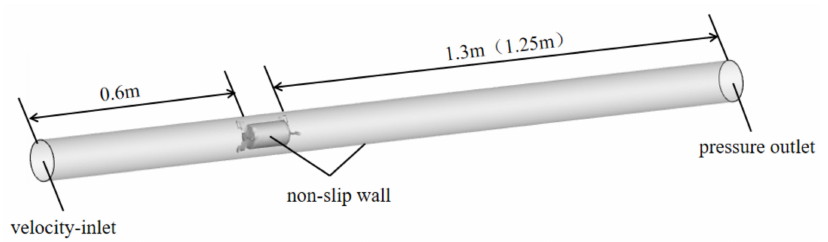
Figure 2. Computational domain and boundary conditions.